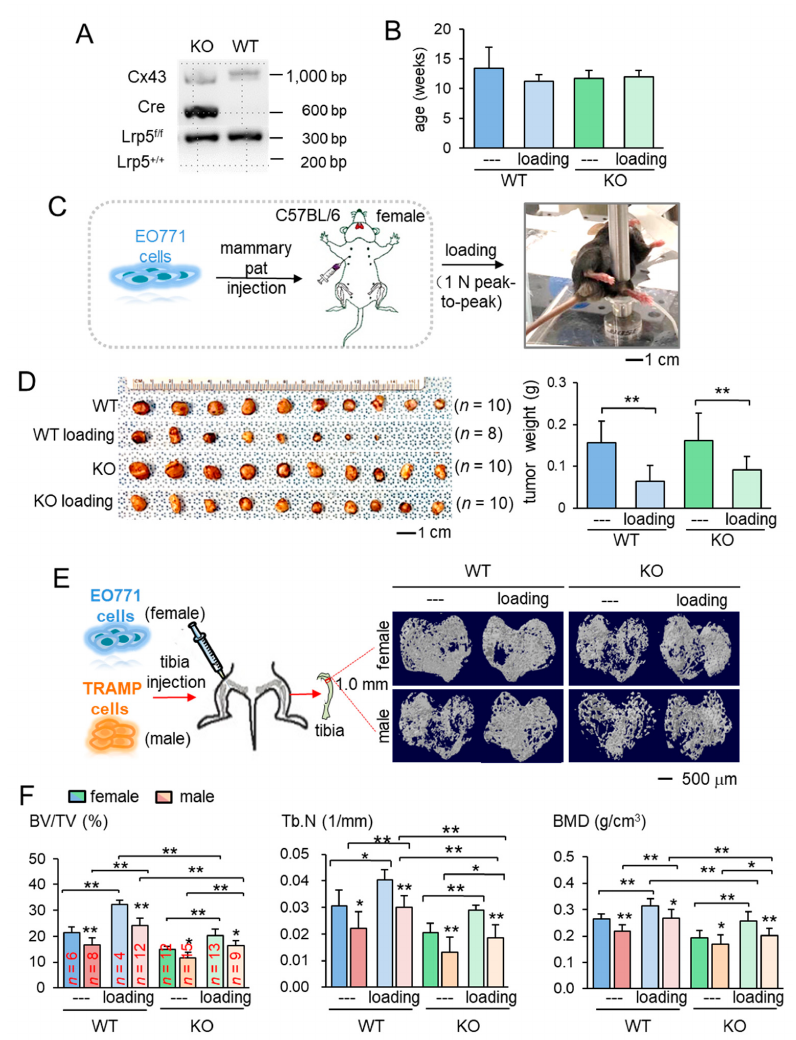
Figure 1. Loading-driven reduction in tumor progression. KO = knockout, and WT = wild-type. The single and double asterisks indicate p < 0.05 and p < 0.01, respectively. ( A ) Genotyping of wild-type and knockout mice. Cre was driven by the BMP1 promoter, and C x 43 was used as an internal control. The genotypes of a pair of mice (KO and WT) were shown based on amplified PCR products, including floxed Lrp5 (f/f), and Lrp5 (+/+) alleles. ( B ) Age of the mice used in this study. ( C ) Procedure for the inoculation of EO771 mammary tumor cells and cyclic knee loading. ( D ) Images of mammary tumors in four groups (wild-type and knockout with and without knee loading). ( E ) Micro CT images of the proximal tibiae of the wild-type and knockout mice with and without knee loading. Female mice received EO771 mammary tumor cells, while male mice received transgenic adenocarcinoma of the mouse prostate (TRAMP) prostate tumor cells in their proximal tibia. ( F ) Three micro CT-linked parameters in the proximal tibiae in the wild-type and knockout mice. BV/TV = bone volume ratio, Tb.N = trabecular number, and BMD = bone mineral density